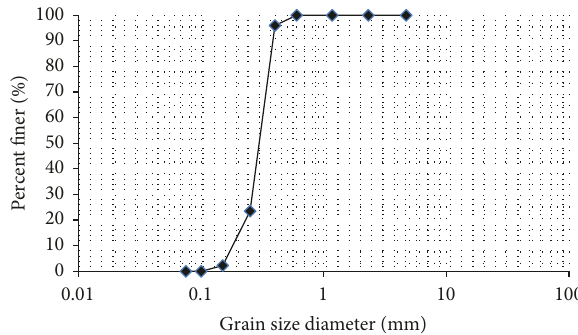
Figure 1: Grain Size distribution of the uniform sand used in this